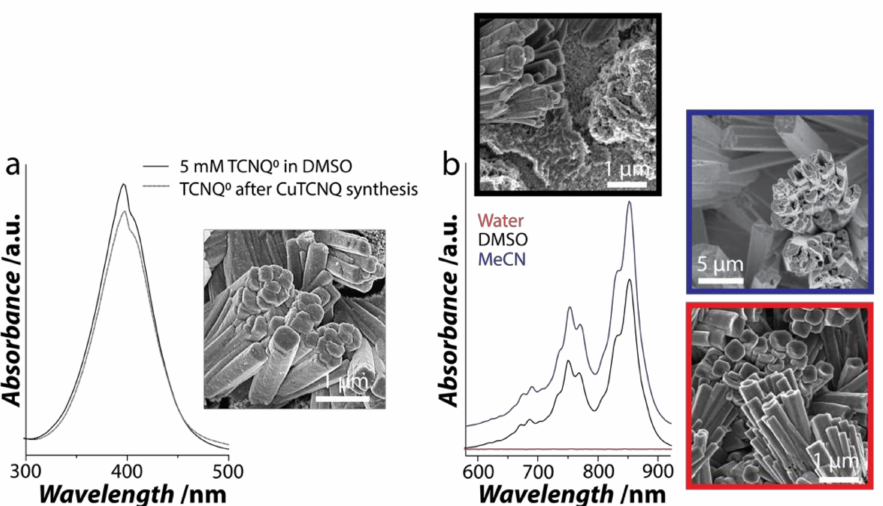
Figure 1. Crystallization and dissolution of CuTCNQ. ( a ) UV-Vis spectra of TCNQ 0 solution in DMSO before and after CuTCNQ synthesis and the SEM image of CuTCNQ formed on the Cu foil via crystallization in DMSO ( b ) UV-Vis absorbance spectra and the SEM images obtained after exposure of CuTCNQ to MeCN, DMSO and water for one hour at room temperature. TCNQ =